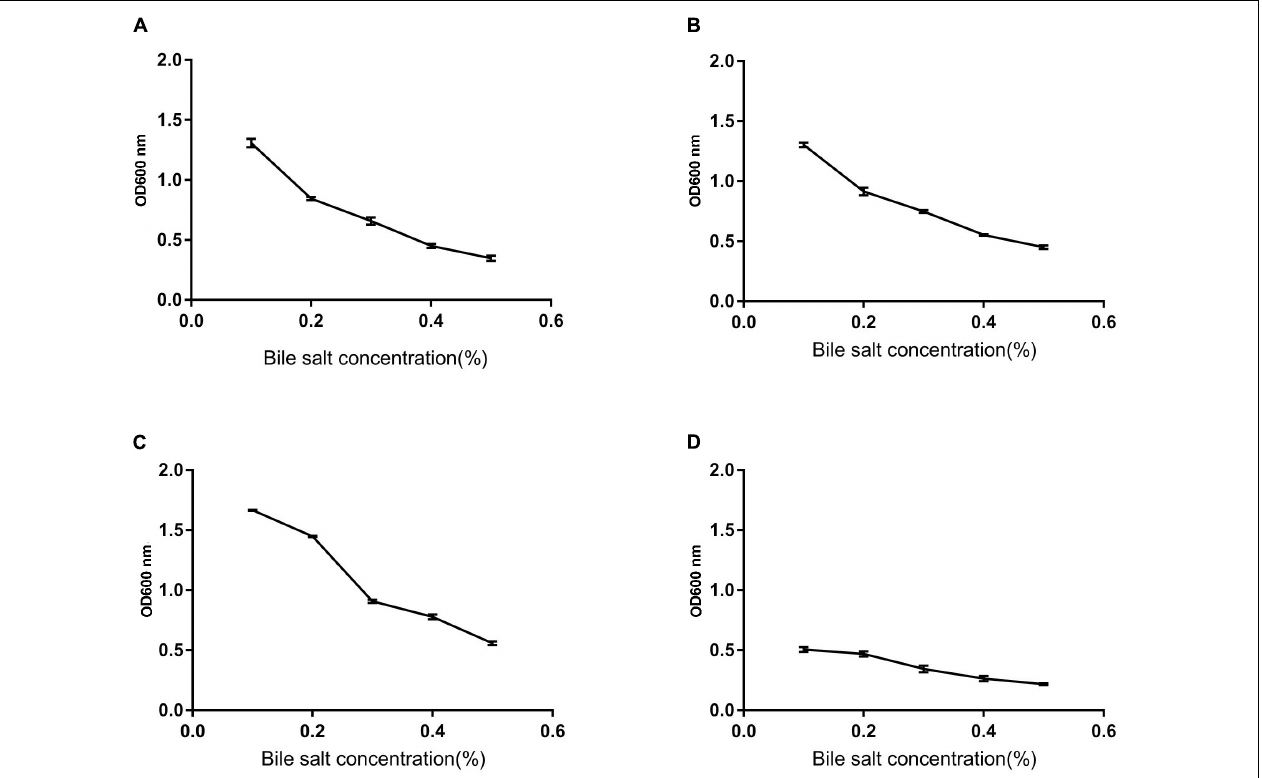
FIGURE 5 | The survival rate of strains under different bile salt concentrations. (A) The result determines tolerance to bile salts of Z1. (B) The result determines tolerance to bile salts of Z2. (C) The result determines tolerance to bile salts of J. (D) The result determines tolerance to bile salts of